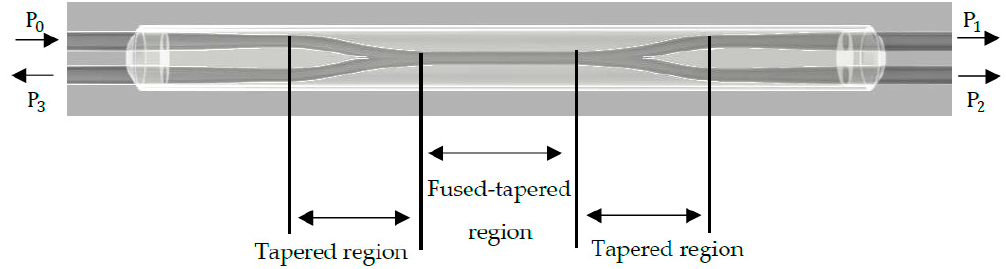
Figure 3. A schematic illustration of a bi-directional 2 × 2 fused tapered coupler. P 0 represents the light input. P 1 and P 2 represent the throughput and coupled power outputs. P 3 represents the bi-directional (backward / cross-talk) light propagation.